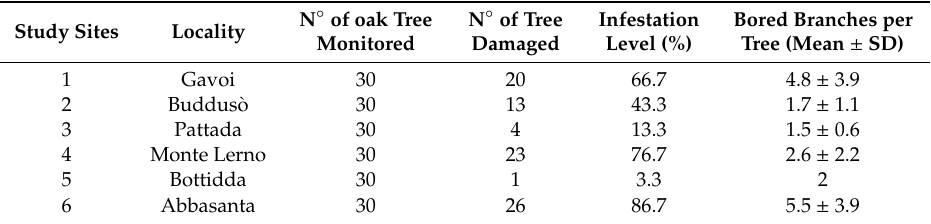
Table 2. Coraebus florentinus infestation level (%) recorded at the study sites.